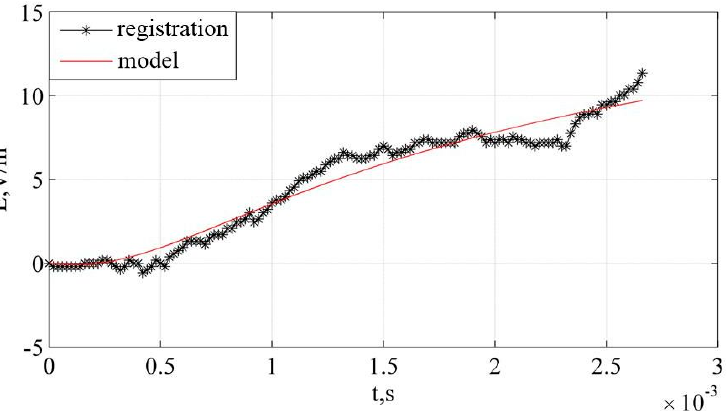
Figure 10. Model result of the close positive lightning leader E-field change, which is related to Case #4 from Table 1 (see also Figure 4). Note that both curves are superimposed on each other; therefore, visibility of the fitted curve is difficult to recognize.